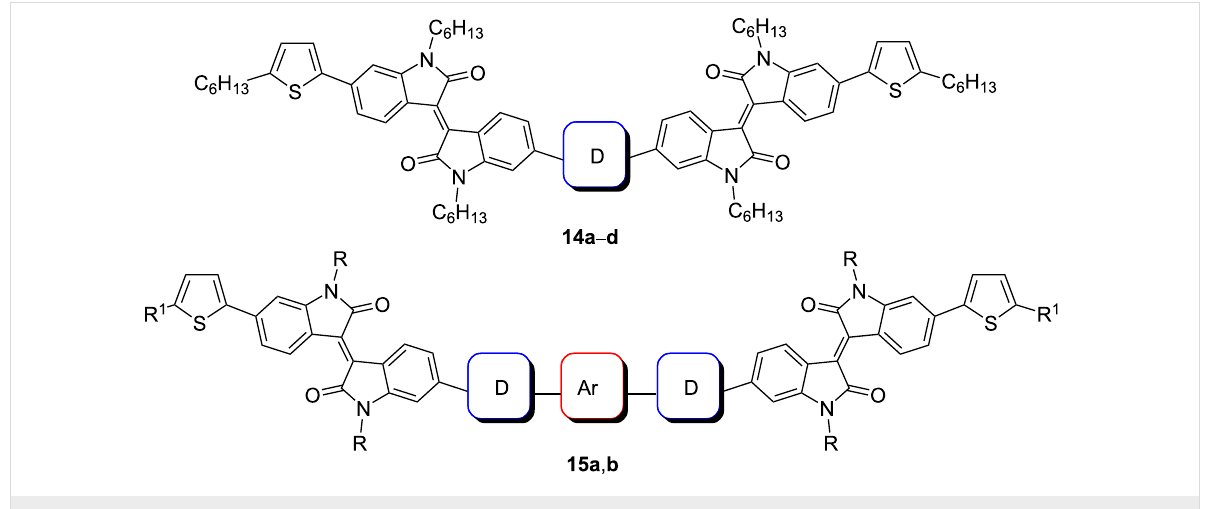
Scheme 10: Bisisoindigos with different linker